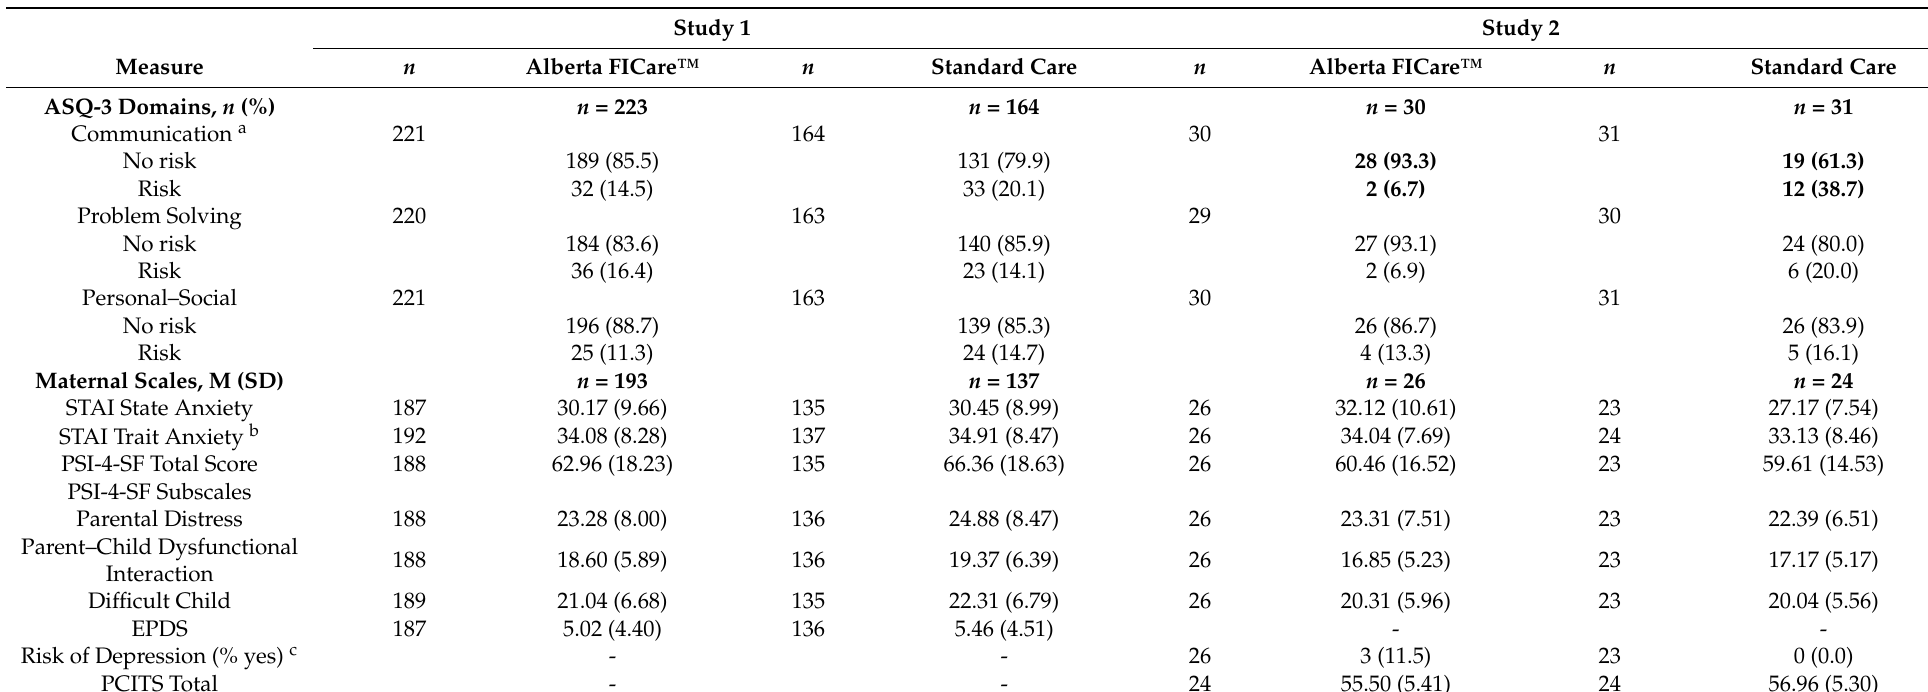
Table 3. Scale scores.